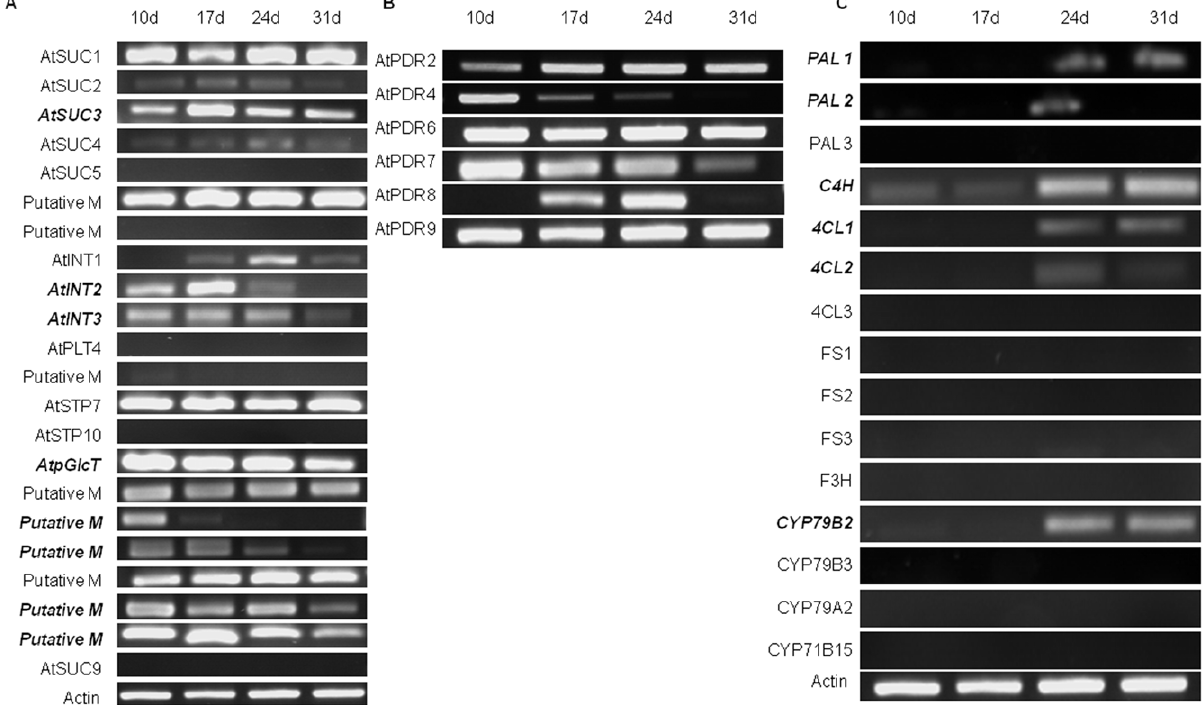
Table 1. Correlation of the compounds identified in the root exudates with the abundance or number of functional genes in each sample.